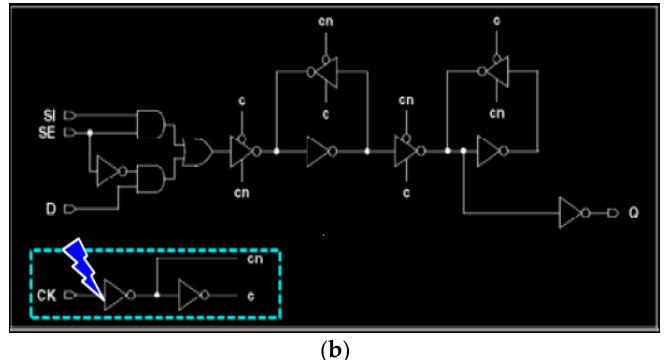
Figure 17. ( a ) The faulty scan chain illuminated (Image overlay in MaskView) ( b ) Schematic view of the clock driver highlighted.